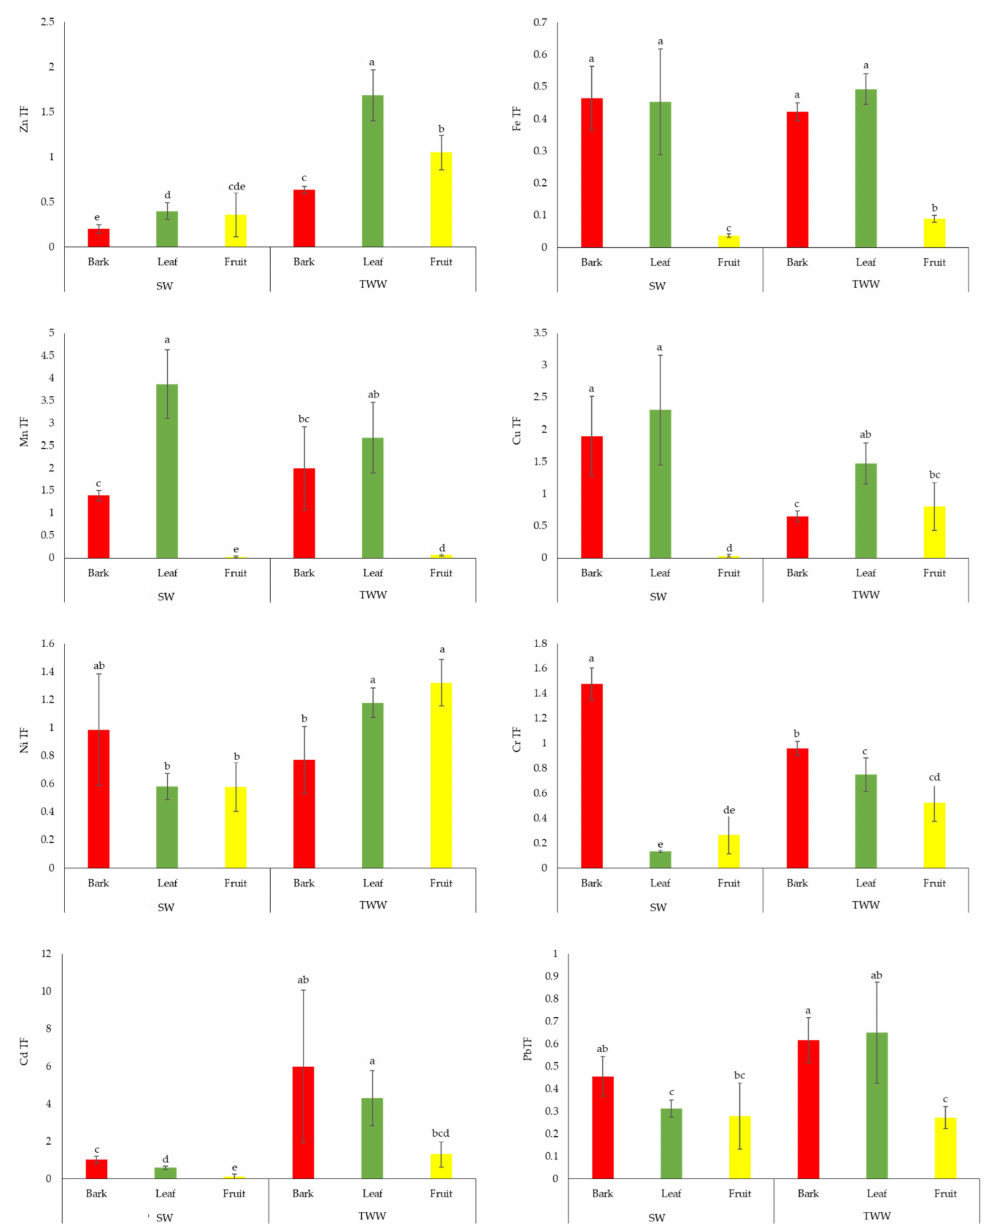
Figure 2. Translocation factors (TF) of different heavy metals in different parts of lemon trees irrigated with treated wastewater (TWW) and spring water (SW) in the Wadi-Musa region. Bars represent mean ± SD ( n = 4). Different letters indicate significant differences according to LSD ( p <